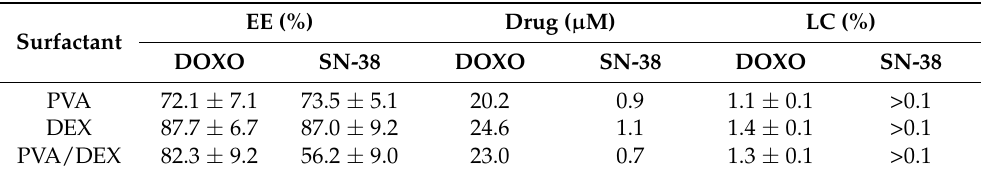
Table 2. Encapsulation efficiency (EE, %), concentration of encapsulated drug and loading capacity (LC, %) of the NPs prepared with the different surfactants and the two drugs. EE (%) Drug ( µ M) LC (%) Surfactant DOXO SN-38 DOXO SN-38 DOXO